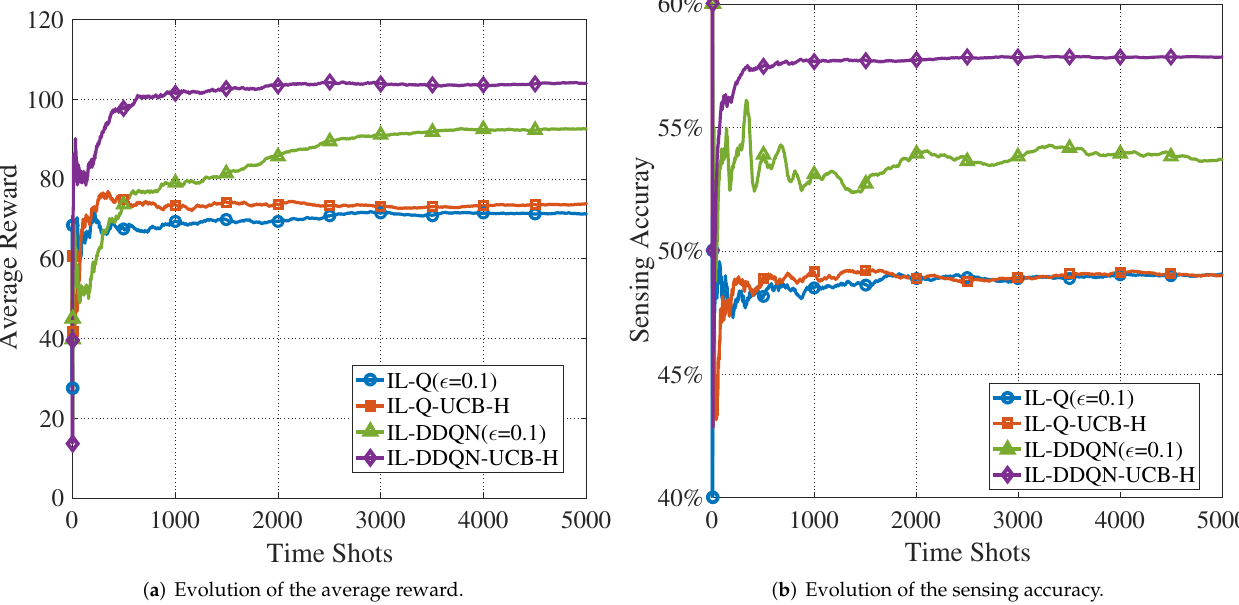
Figure 6. Evolution of the average reward and the sensing accuracy with training ( N = 4, M = 5).